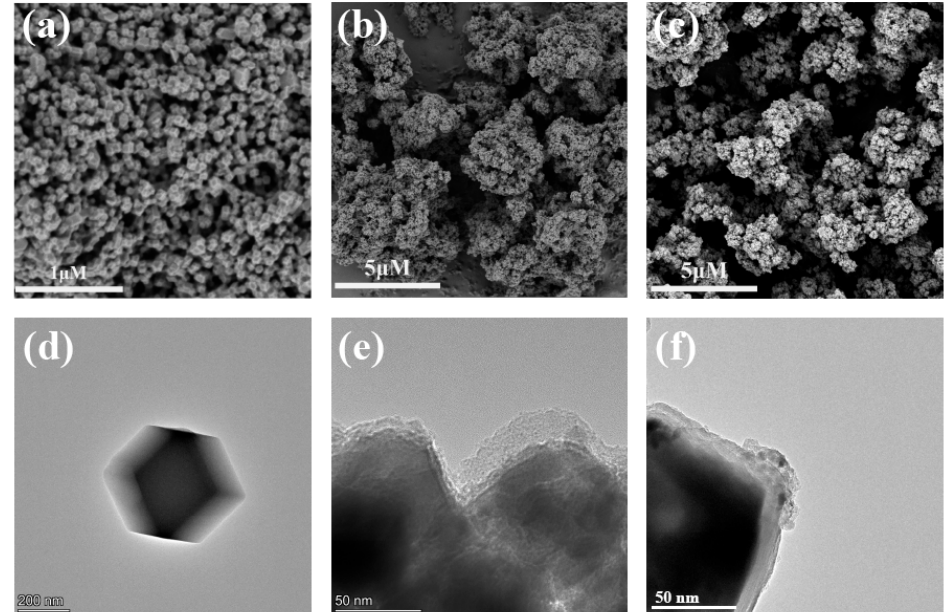
Figure 1. SEM images of ZIF-8 ( a ), N, S-GQDs@ZIF-8@MIP ( b ) and N, S-GQDs@ZIF-8@NIP ( c ); TEM images of ZIF-8 ( d ), N, S-GQDs@ZIF-8@MIP ( e ) and N, S-GQDs@ZIF-8@NIP ( f ).